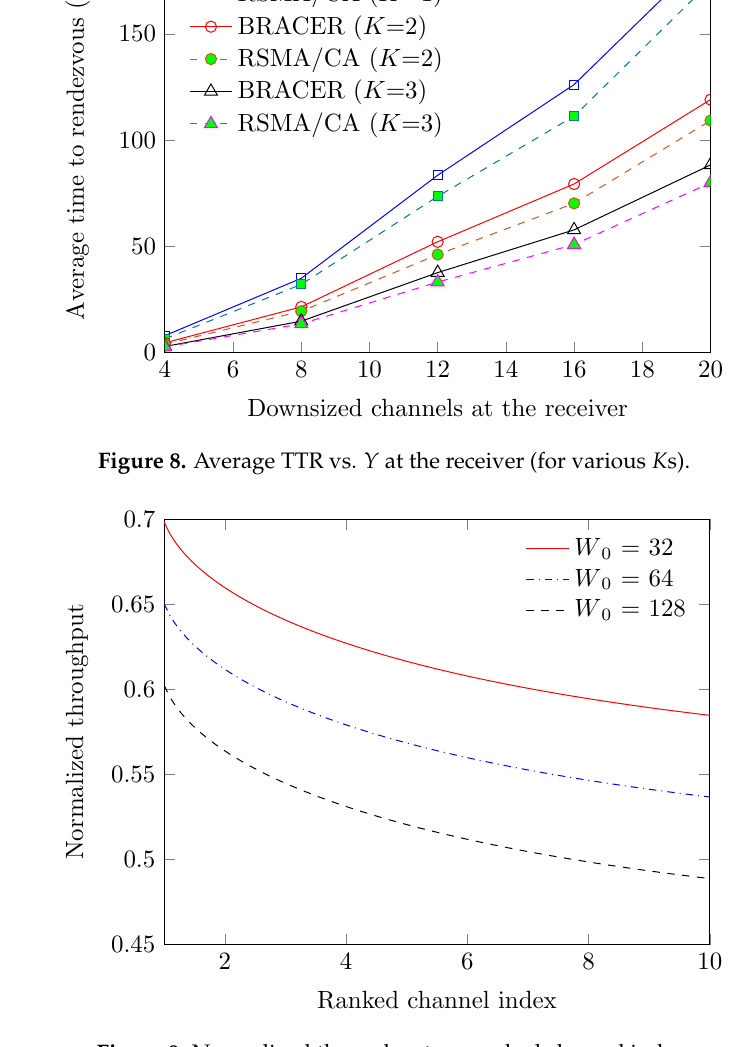
Figure 9. Normalized throughput vs. ranked channel